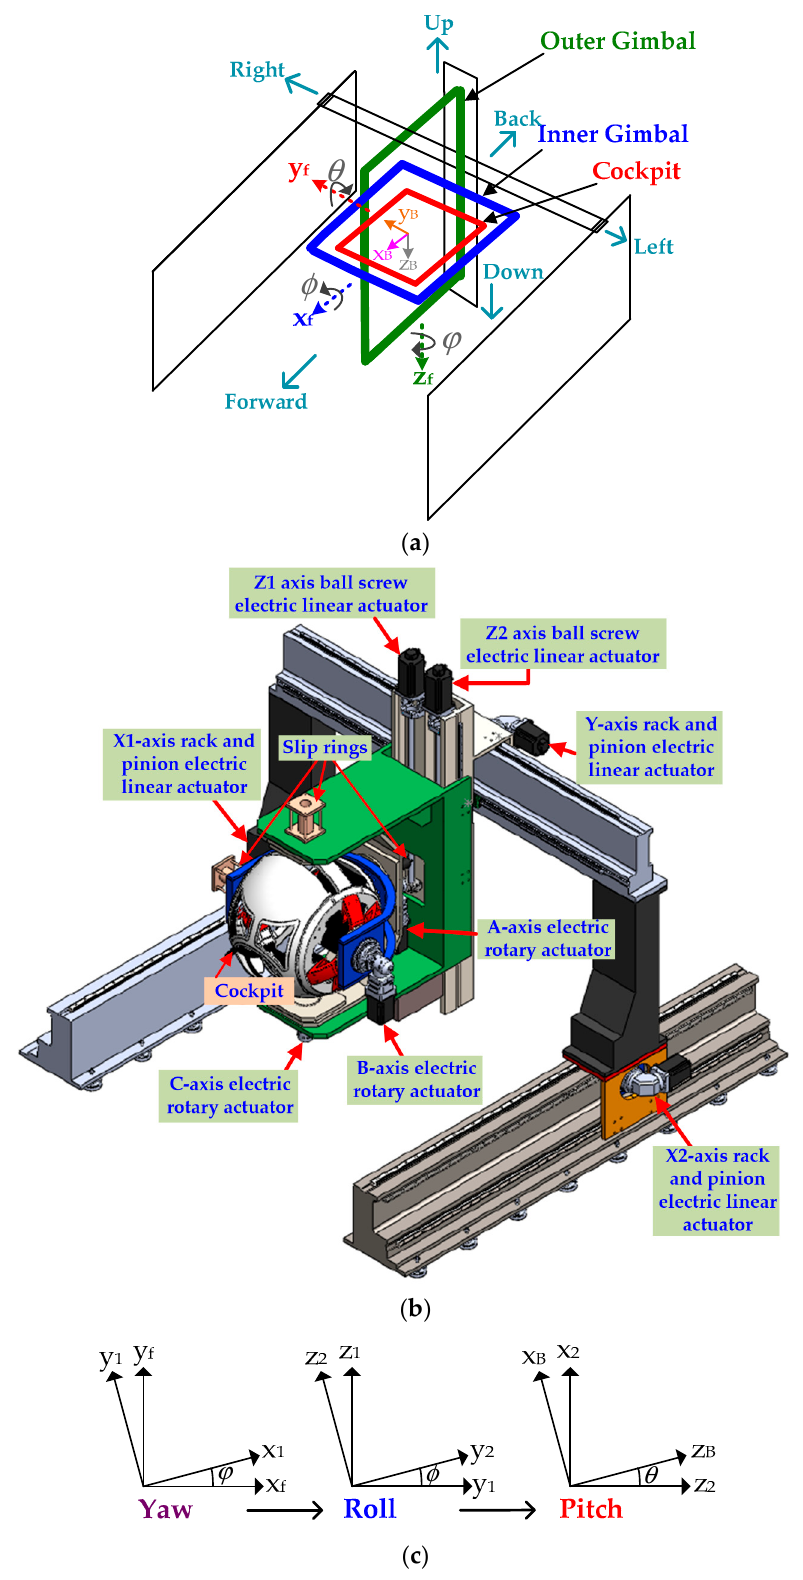
Figure 1. Six-DoF platform: ( a ) configuration of the co-ordinate system, ( b ) 3D design drawing, and ( c ) rotation relationship. The co-ordinate conversion relationship is: